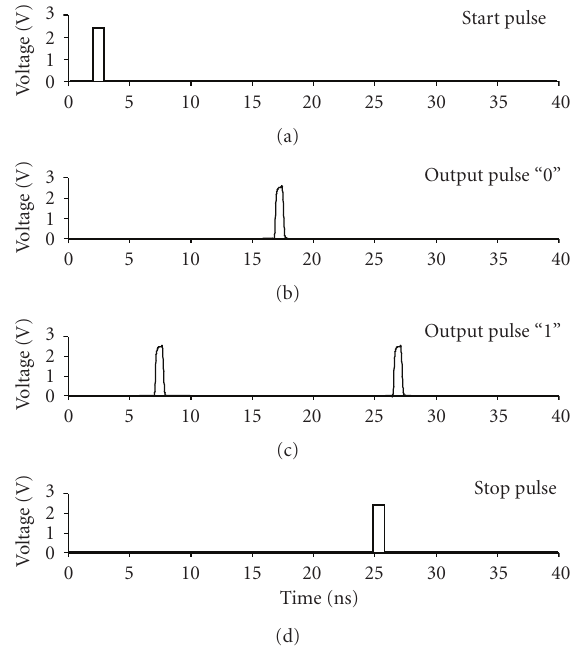
Figure 15: Simulation results of the ring oscillator.